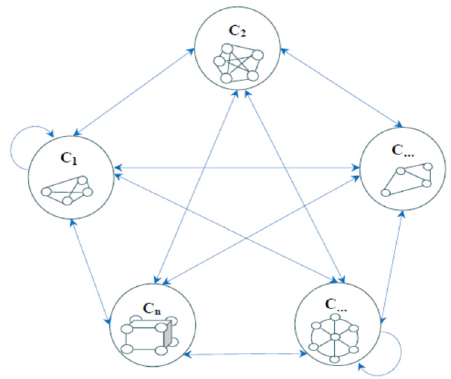
Figure 2. An ANP model structure.